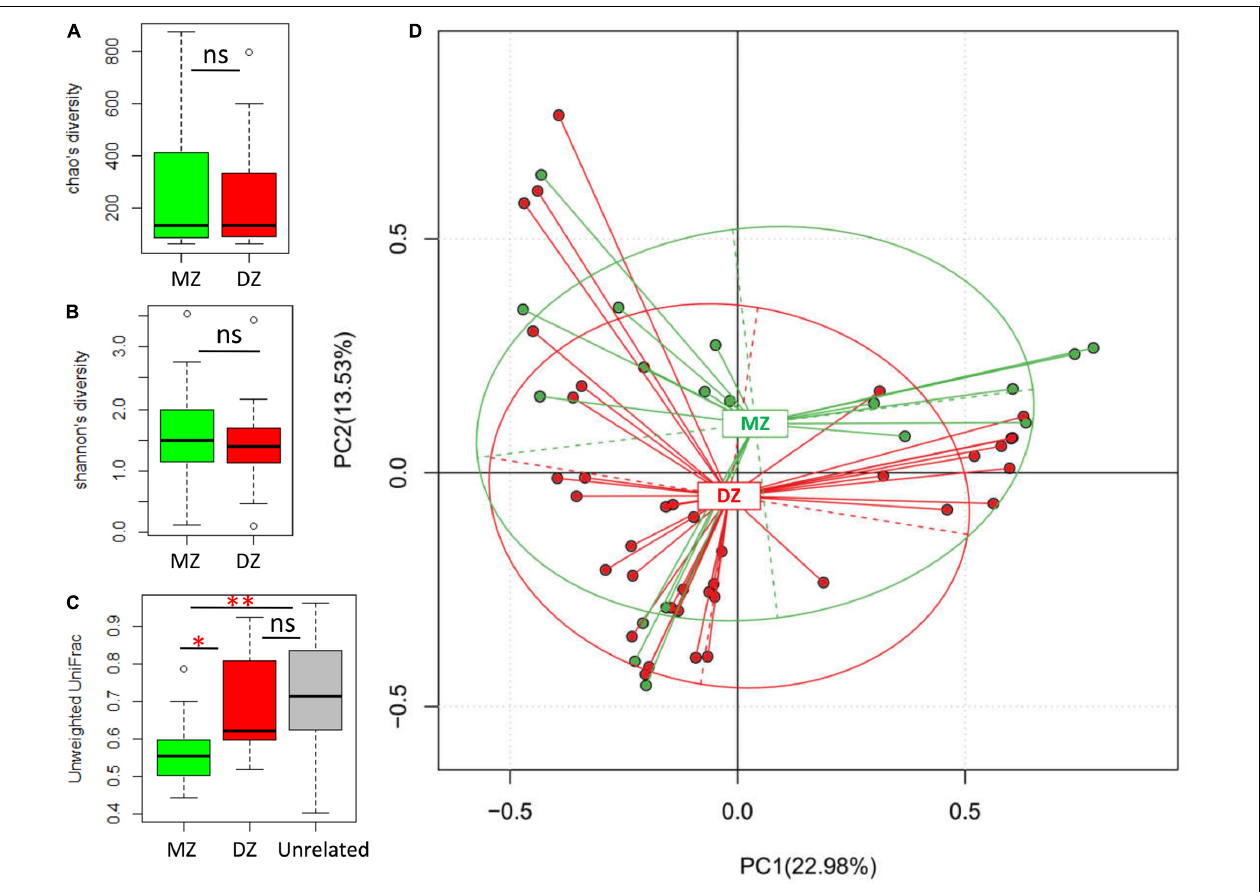
FIGURE 1 | Microbial comparisons between DZ and MZ twins. (A,B) Alpha diversities of DZ and MZ using the Chao and Shannon indices. (C) Unweighted UniFrac distances between microbial communities obtained by comparing individuals within twinships for DZ and MZ twin pairs, and between unrelated individuals (Unrelated). (D) Principal component analysis (PCA) plot based on the relative taxa abundance in the microbiomes of DZ and MZ neonates. ns, not significant. * p < 0.05, ** p <